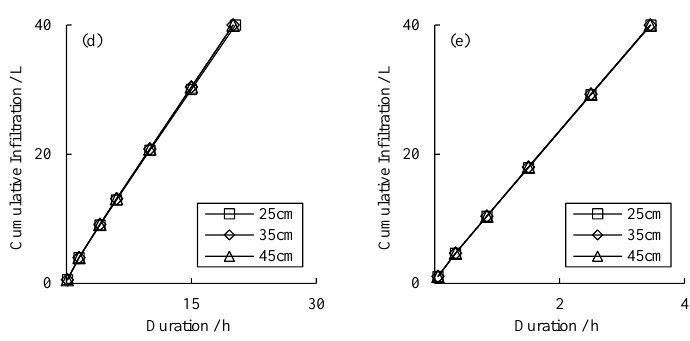
Figure 3. Effect of tube burial depth on cumulative infiltration from a vertical line source irrigation.